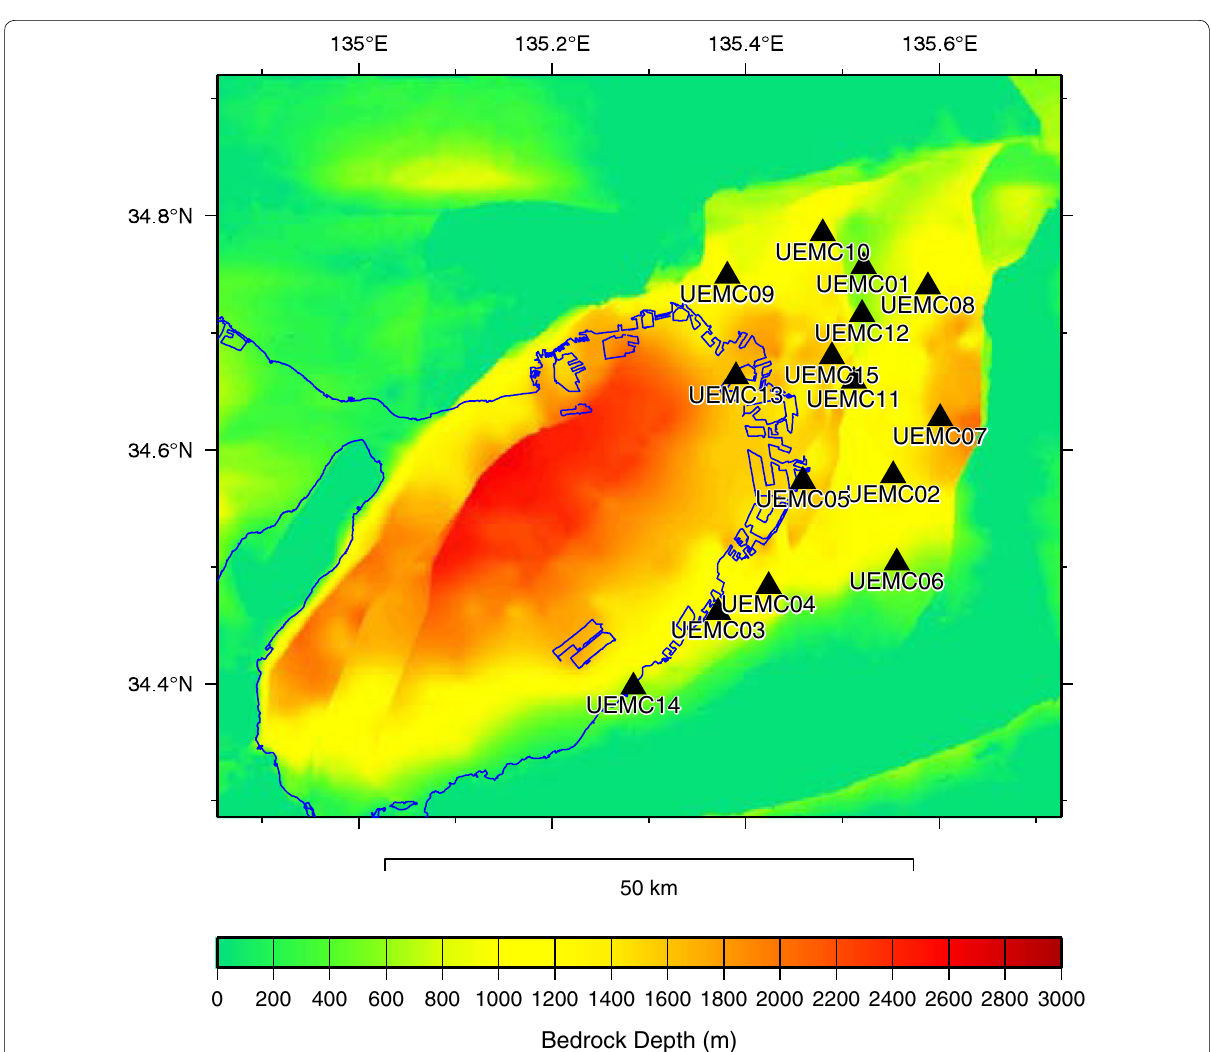
Fig. 1 Temporary observation stations in the Osaka basin ( black triangles ) shown with bedrock depths from the UMC2013 model (Sekiguchi et al.